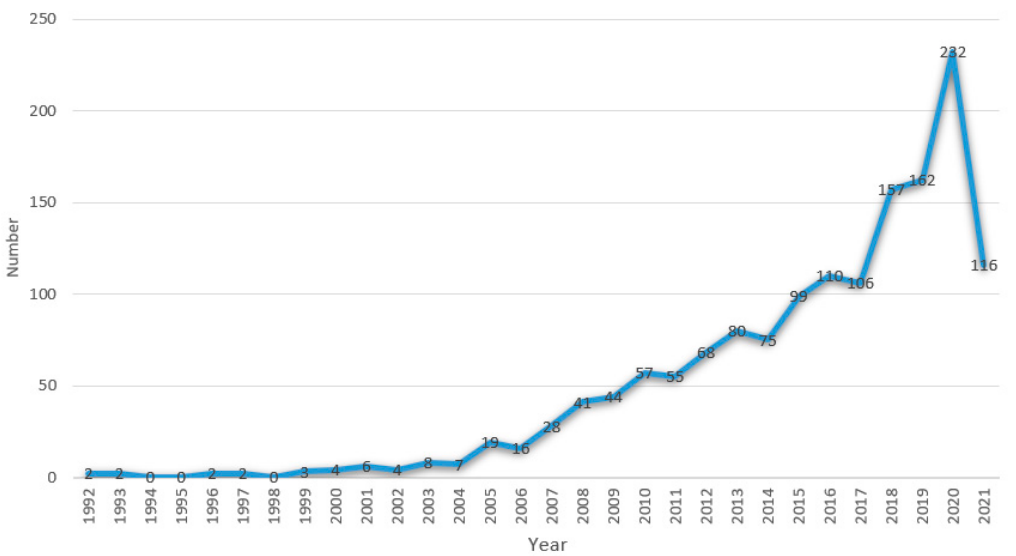
Figure 2. The annual number of publications on HC research in China from 1992 to 2021.